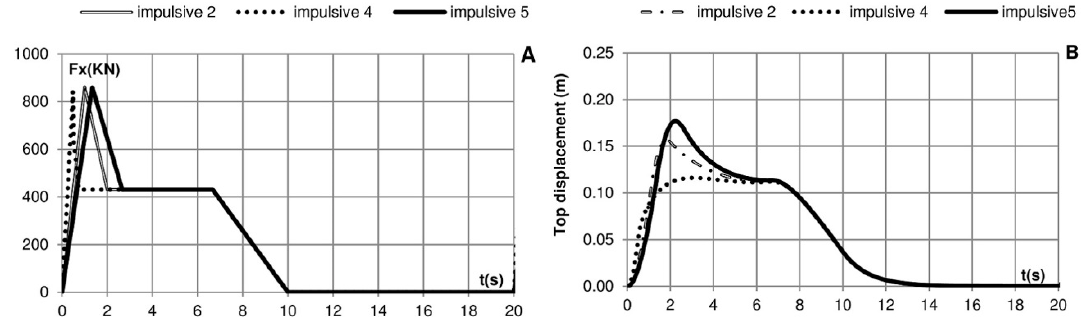
Figure 16. Rise time influence: ( A ) shape of the signals; ( B ) movements on the top of the foundation.